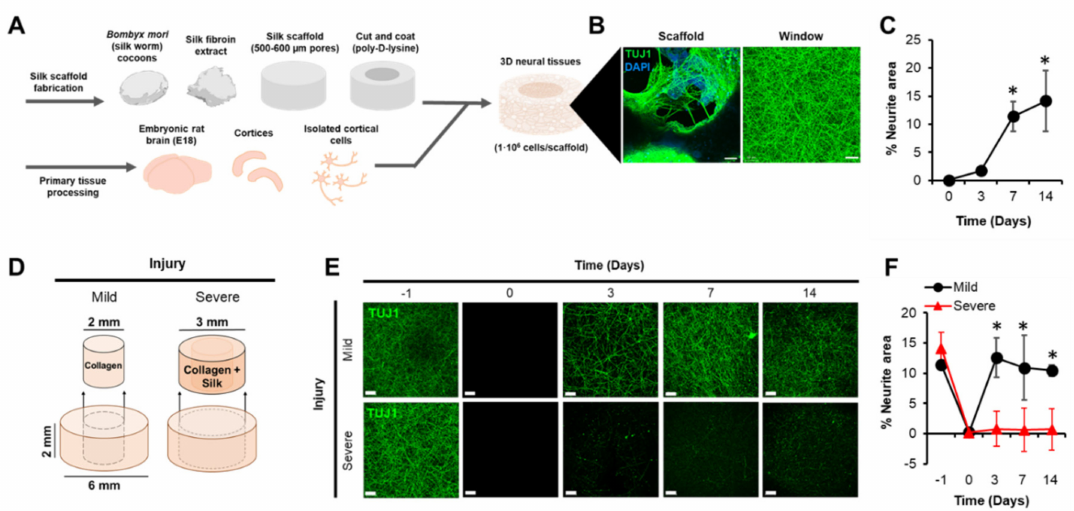
Figure 1. 3D neural tissues were fabricated and injured to model a laceration-based traumatic brain injury (TBI).( A )Primarycorticalneuronswereharvestedfromdissociatedembryonic(E18)ratcorticesandinjected into a toroidal, silk-based scaffold. ( B ) Both the Scaffold and Window regions contained a diffuse network of neurites as revealed by immunocytochemistry (TUJ1 green, DAPI blue). ( C ) Quantifying neurites